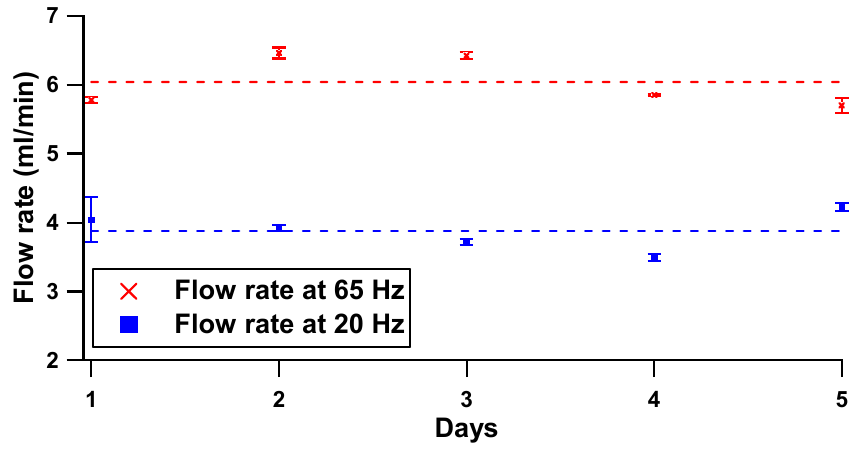
Figure 13. Repeatability and reproducibility Test.